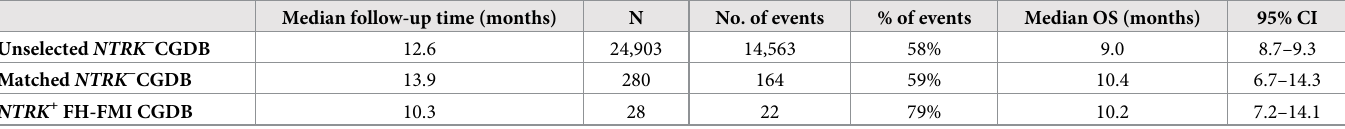
Table 3. OS analysis by cohort (date of diagnosis of locally advanced/metastatic disease used as index). Median follow-up time